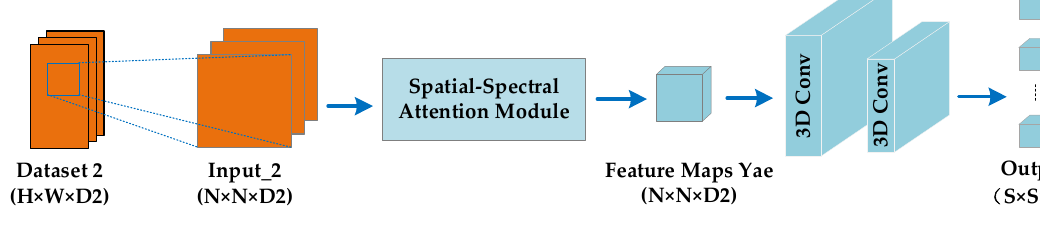
Figure 9. 3DCNN with spatial–spectral attention.